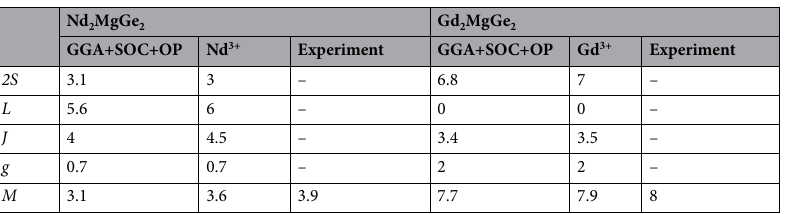
Table 2. Spin moment ( S ), orbital moment ( L ), total moment ( J ), Landé factor ( g ), and total magnetic moment ( M in μ B ). Free atom (RE 3+ ) 56 and experimental 49 values are given for comparison.